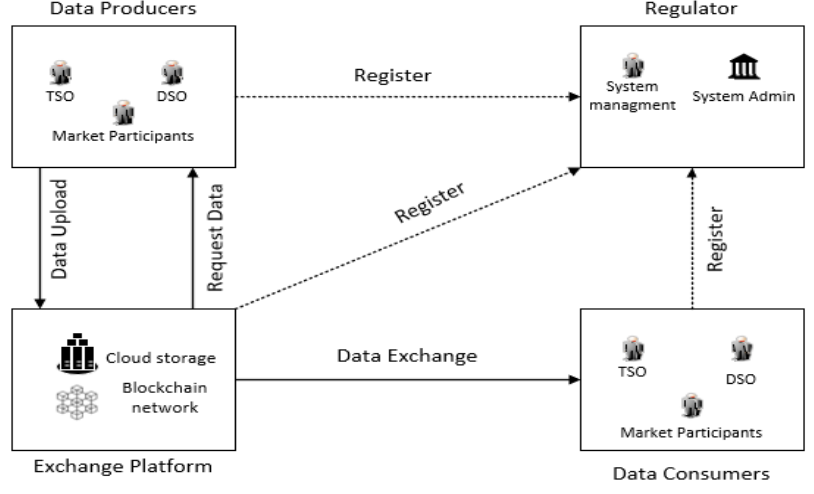
Figure 2. System Figure 2. System participants.